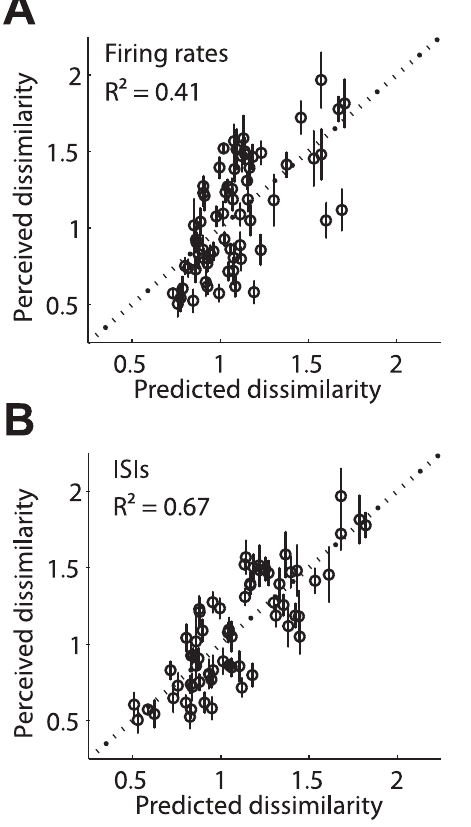
Figure 6. Predicting psychophysical responses to noise stimuli. Predicted versus perceived dissimilarity as calculated from (A) firing rates, and (B) ISIs. Each dot represents the mean perceived dissimilarity of one pair of stimuli. Predictions based on ISI distributions are significantly better than those based on firing rates alone, suggesting that spike timing contributes to perception. Error bars denote standard error of the mean.